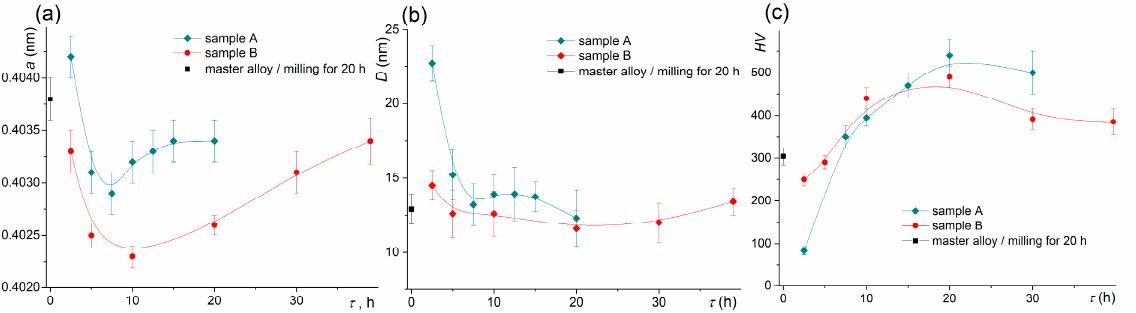
Figure 5. Evolution of ( a ) the lattice parameter, ( b ) the coherent scattering region D , and ( c ) the microhardness during the high-energy ball milling of sample A and sample B.